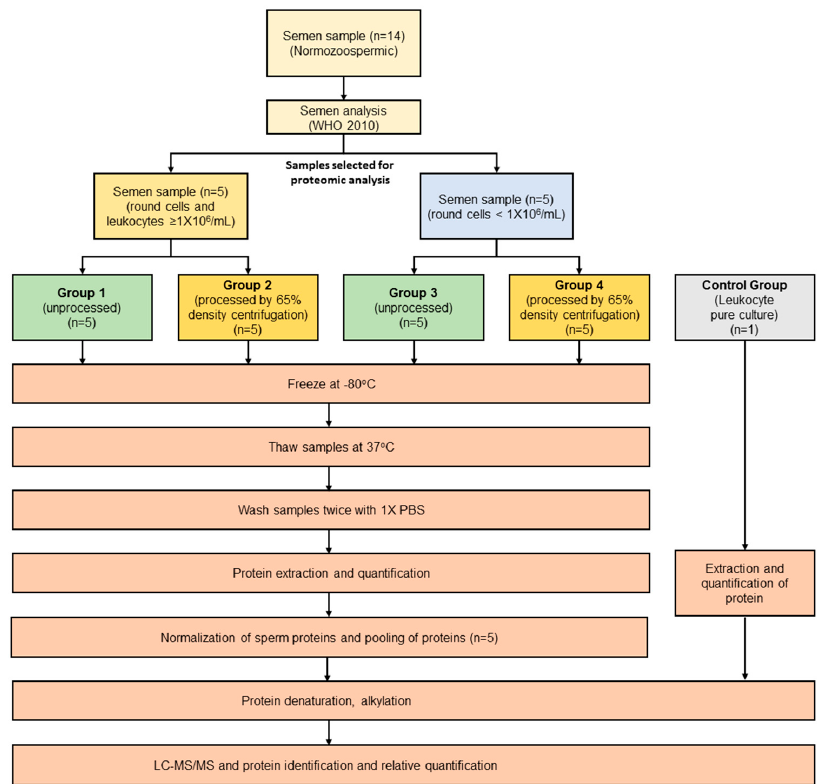
Figure 3. Schematic flowchart of overall experimental design. Normozoospermic samples were divided into four groups. Proteomic profile of sperm was evaluated by LC-MS/MS and compared